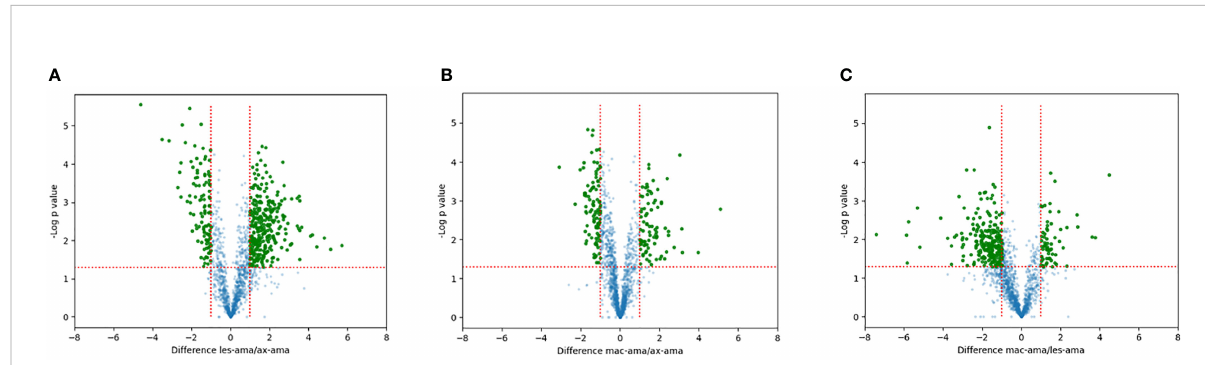
FIGURE 4 Quantitative proteomic analysis. Volcano plot visualization of differentially expressed proteins between (A) lesion-derived amastigotes vs. axenic. (B) macrophage-derived vs. axenic amastigotes. (C) macrophage-derived vs. lesion-derived amastigotes. Green dots correspond to proteins showing increased or reduced abundance (fold change ≥ 2, p-value < 0.05). Blue dots represent proteins that didn ’ t differ in each